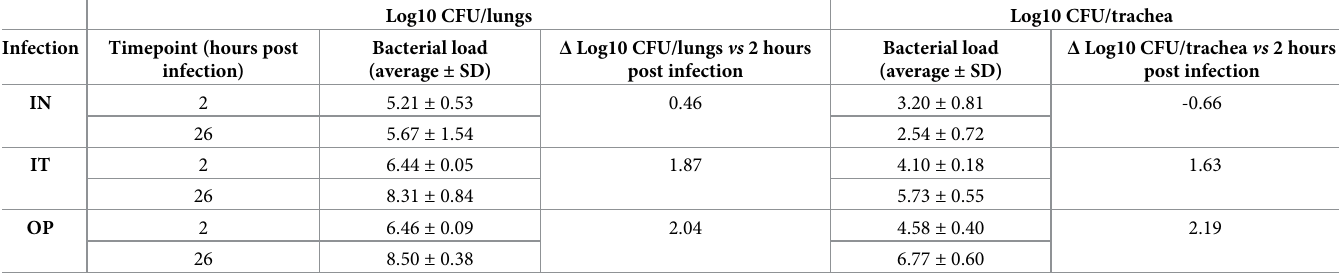
Table 3. Bacterial load in tissues of A . baumannii ACC002 infected